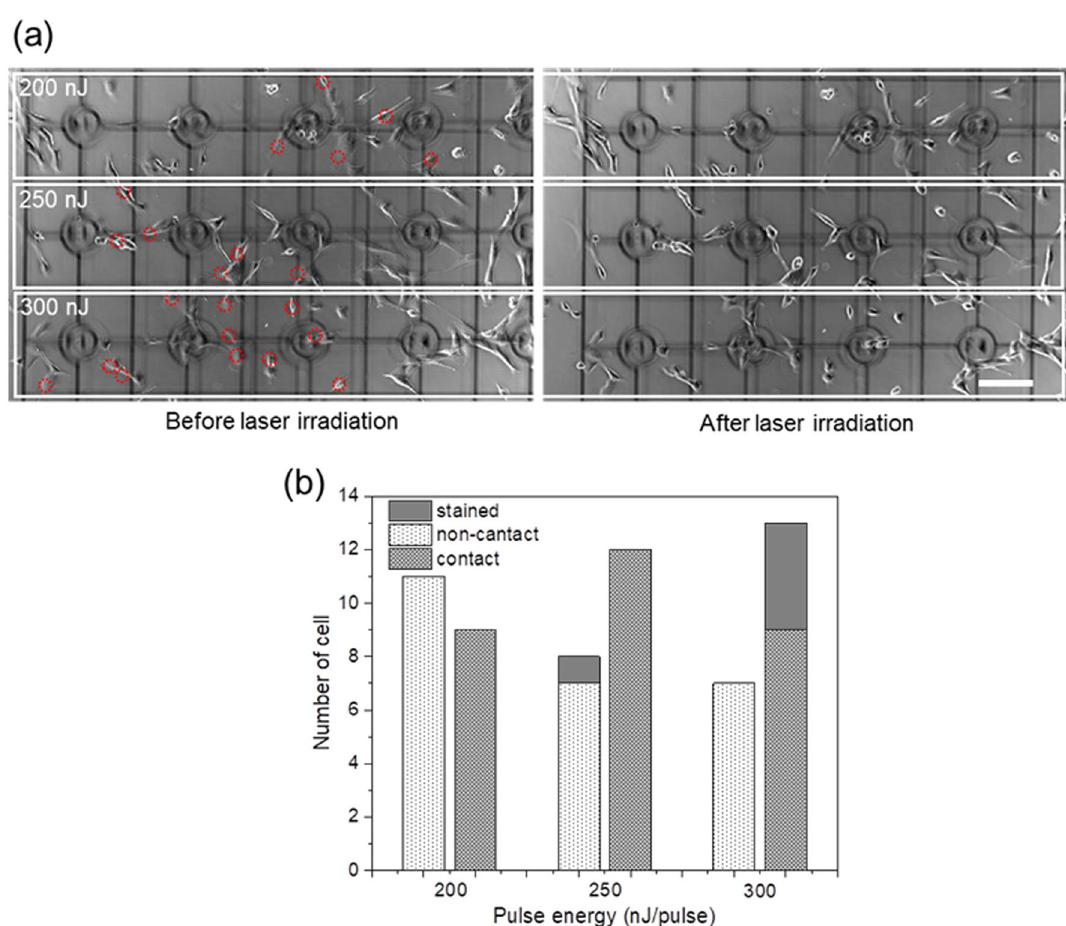
Figure 3. ( a ) Transmission images of C2C12 before and after laser irradiation with 200, 250, 300 nJ/pulses. Cells were cultured on a cover glass with a 150 μm grid. Cells contacted gas bubbles were marked with red circles. Scale bar is 150 μm. ( b ) A histogram of the number of trypan blue stained cells after the fs laser irradiation with different pulse